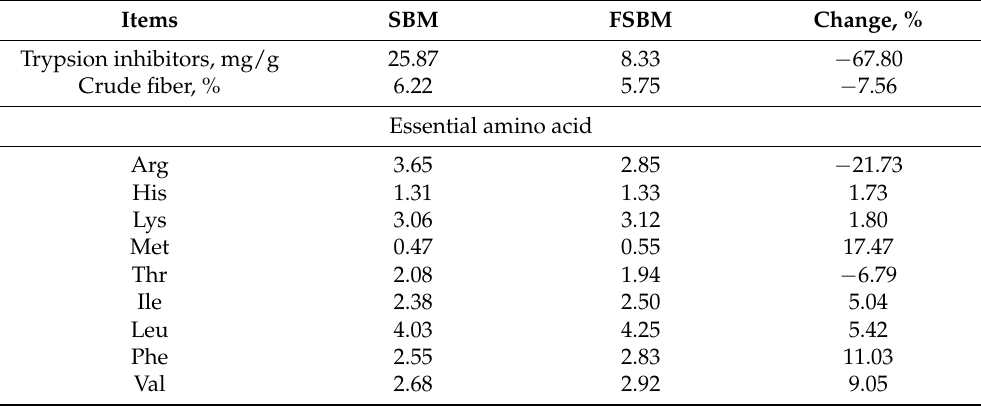
Table 3. The crude protein, TCA-SP, antigenic protein, and amino acid contents of SBM and FSBM (air-dry basis,